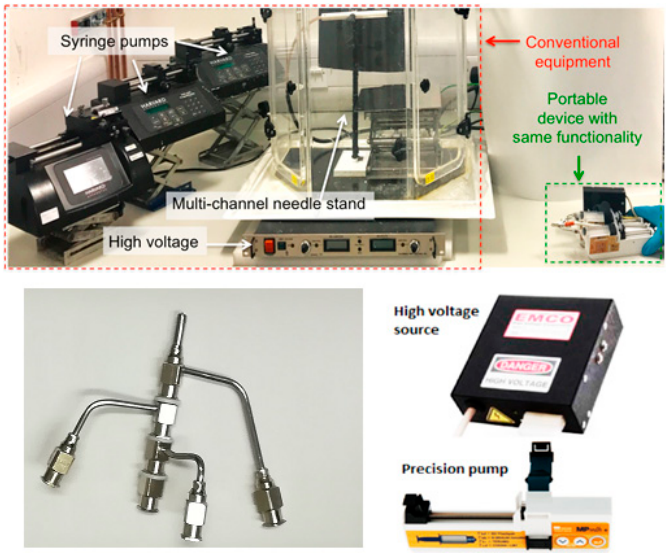
Figure 1. Above: Photograph showing a size comparison between the old conventional large, bench- top setup and the new three-compartment portable electrohydrodynamic device held by a researcher. Below: A photograph of the multiple needle system used to generate three-layered fibers and the high voltage source and precision pump used in developing the device.